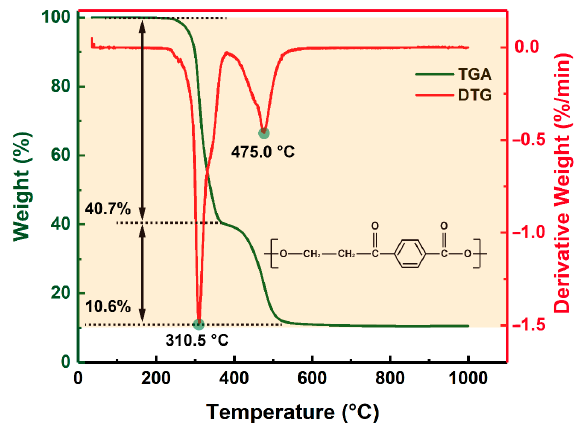
Figure 2. TGA - DTG curves of the PET film. Figure 2. TGA-DTG curves of the PET